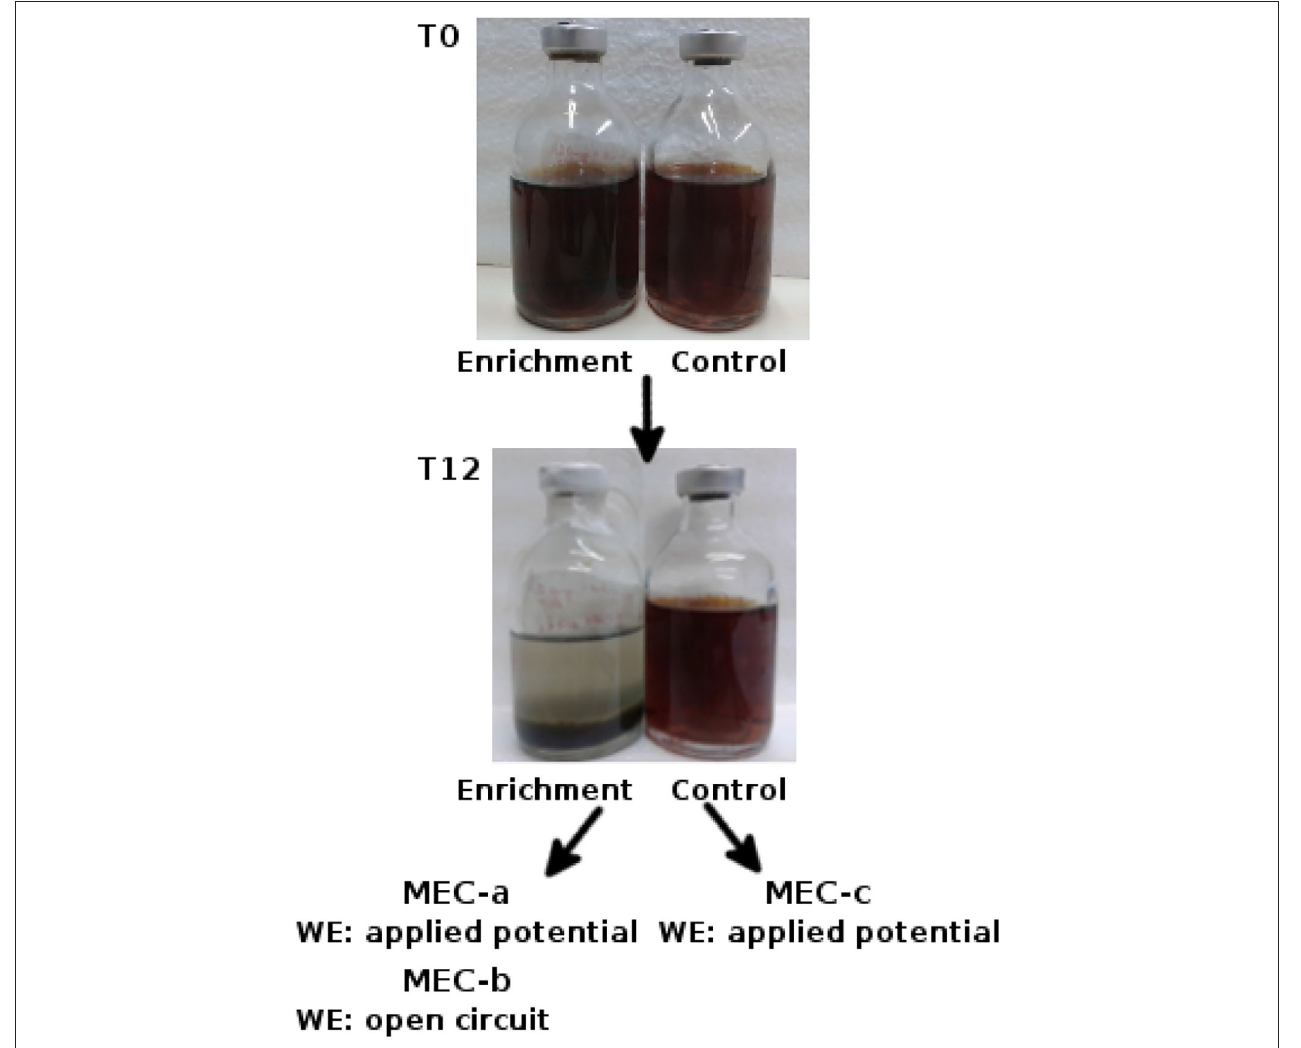
FIGURE 1 | Selection of electrogenic microorganisms from a river sediment. T0 = anaerobic vials inoculated with the river sediment, “enrichment,” or with the sterilized river sediment, “control.” T12 = 12 days after inoculation. Two microbial electrolysis cells (MEC-a and MEC-b) were inoculated with the “enrichment” at T12 and one with the “control” (MEC-c). The working electrode (WE) of both MEC-a and MEC-c was initially poised at +240 mV vs. Ag/AgCl, whereas MEC-b was left at open circuit. The electrogenic microorganisms are expected to be recovered from MEC-a. MEC-b and MEC-c are control experiments: MEC-b was designed in